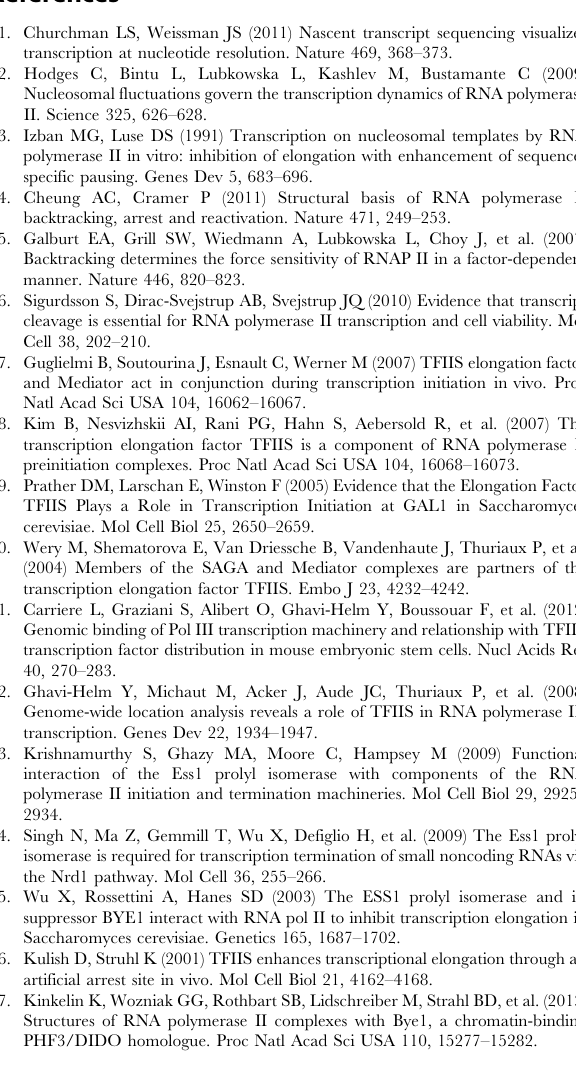
Table S6 List of primers, plasmids and strains used in this study. Table S7 List of class III genes examined in this